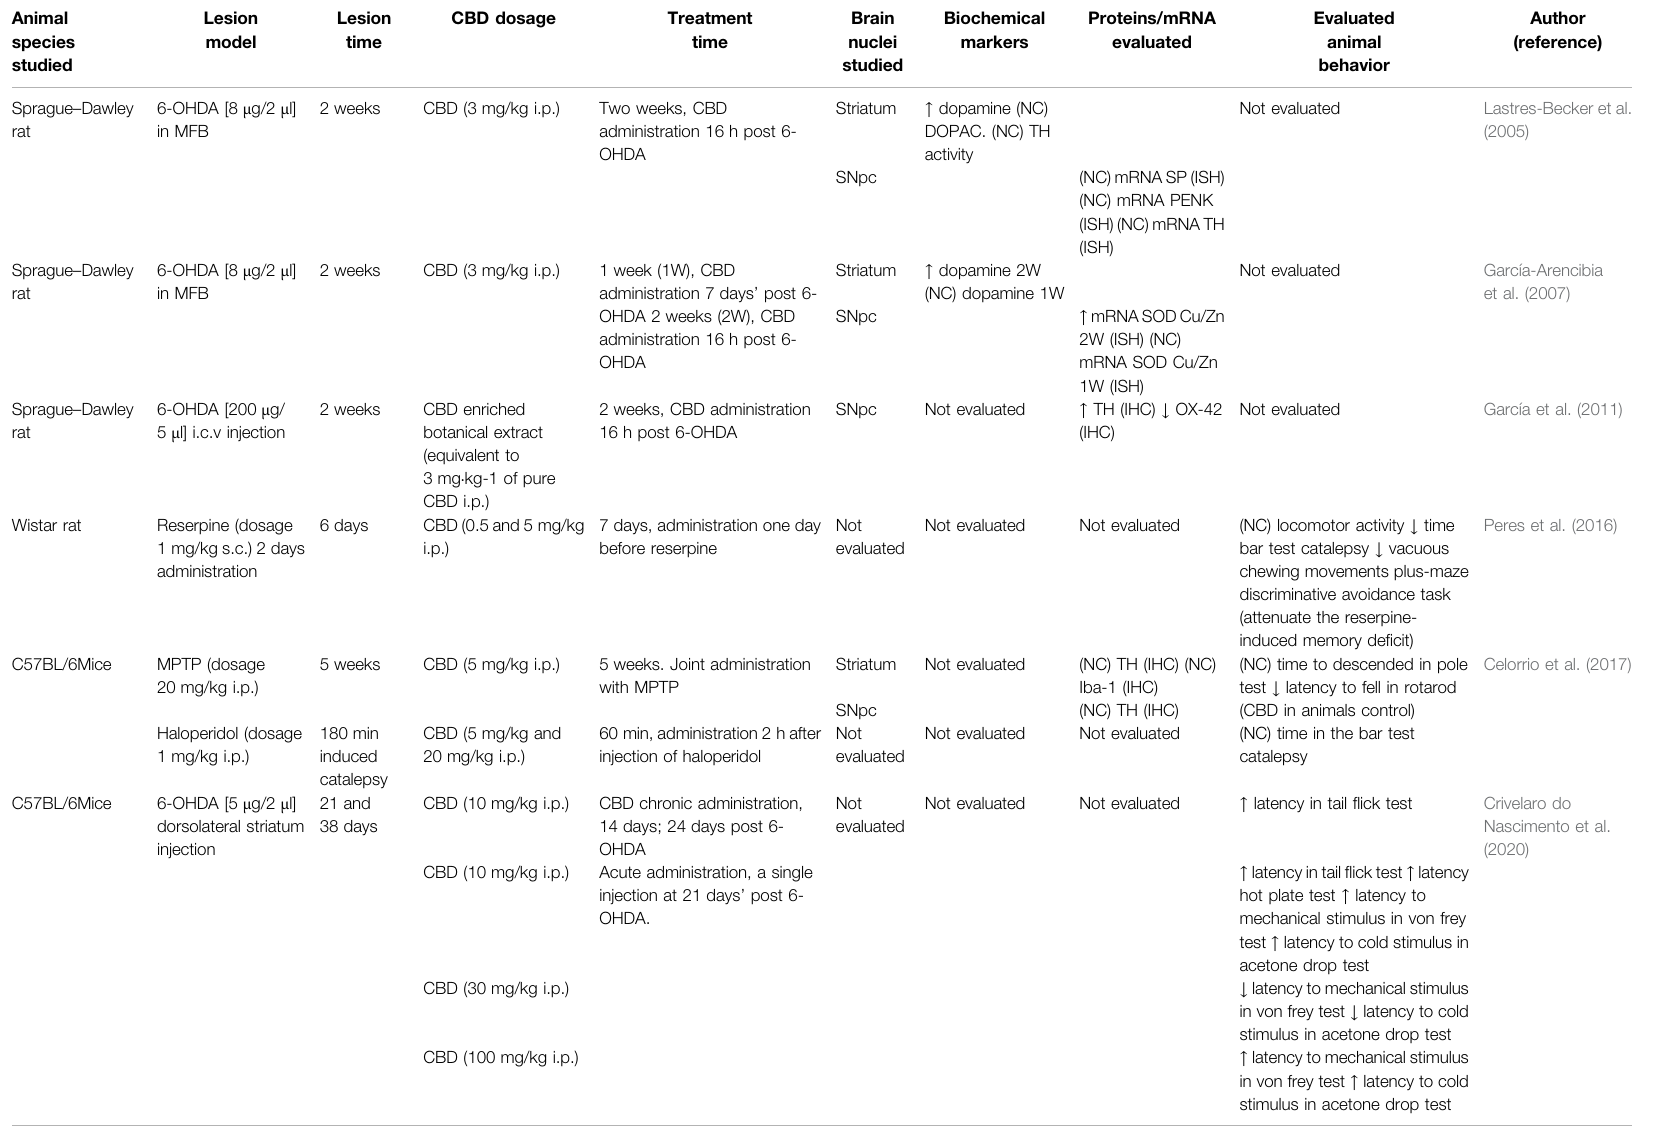
TABLE 2 | Preclinical research reports of effect CBD on various in vivo models of